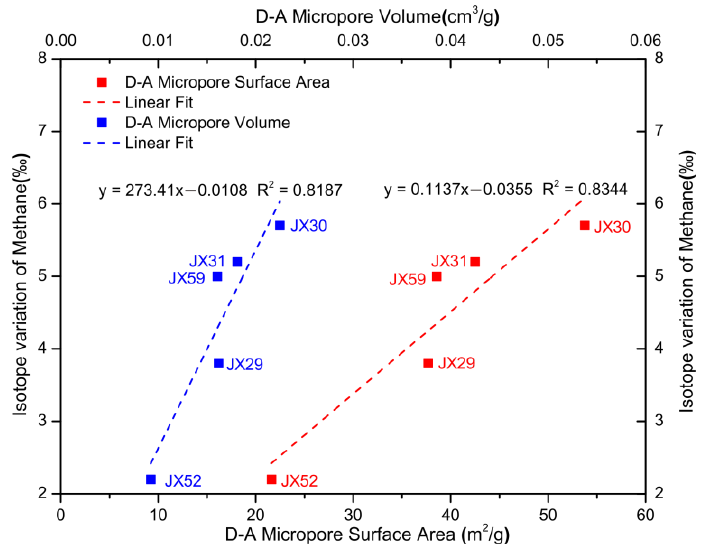
Figure 9. Variation in the values of δ 13 C CH4 with D-A micropore surface area and micropore volume during shale gas degassing.